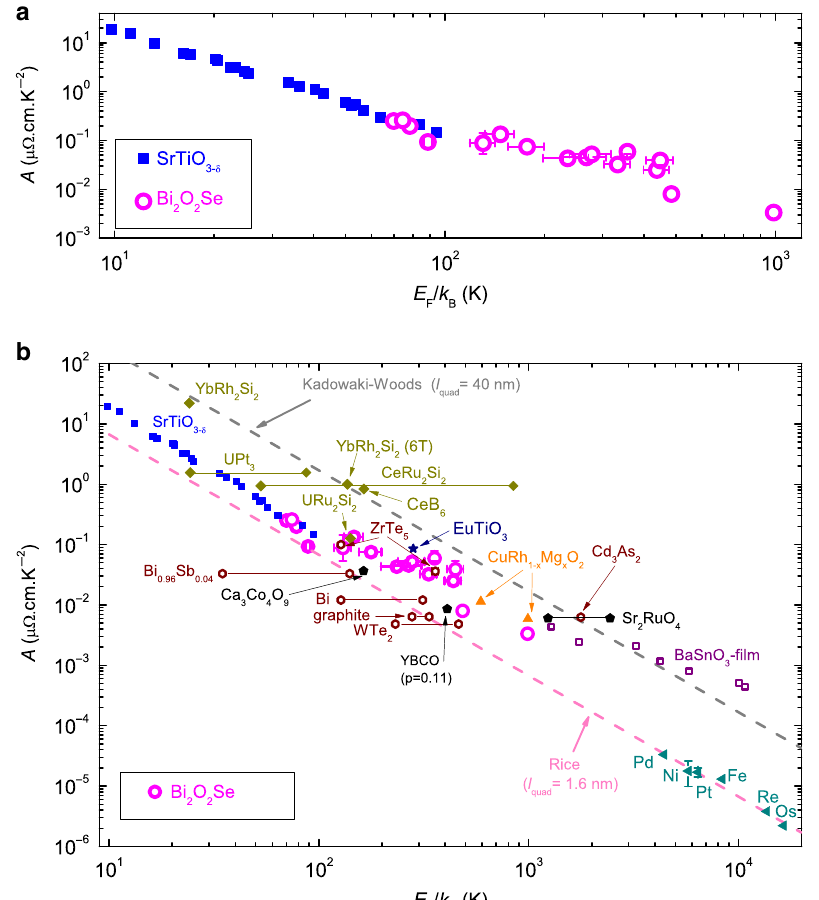
Fig. 4 Universal scaling between the slope of T 2 resistivity ( A ) and Fermi energy ( E F ). a Variation of A with E F on a Log – Log scale for Bi 2 O 2 Se: open magenta circles, compared to SrTiO 3 : solid blue squares 7 . b A − E F plot across various FLs, such as Metals: solid dark cyan triangles; strongly correlated metals including heavy Fermions: solid dark yellow diamonds and YBCO (YBa 2 Cu 3 O y ), Sr 2 RuO 4 , Ca 3 Co 4 O 9 : solid black pentagons; semimetals including Bi, Bi 0.96 Sb 0.04 , graphite, WTe 2 , Cd 3 As 2 , and ZrTe 5 : open wine hexagons; doped semiconductors including Bi 2 O 2 Se, SrTiO 3 , BaSnO 3 : open purple squares, CuRhO 2 : solid orange triangles, EuTiO 3 : solid navy star 7,8,30,46,47 . Most of the data are bounded by the two dashed lines set by Kadowaki – Woods and